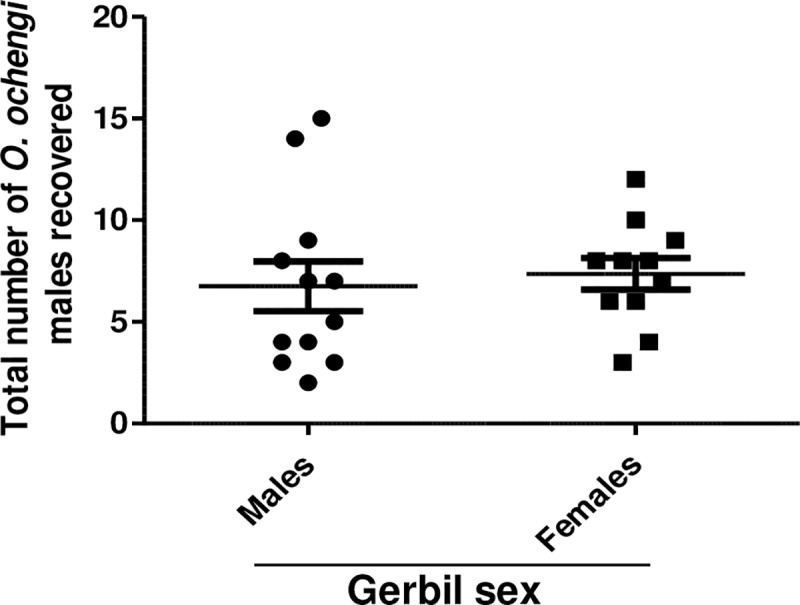
Comparison of O. ochengi male worm recovery in male and female gerbils.Gerbils were implanted with 20 O. ochengi males, sacrificed 35 days later and analyzed for total number of male worms recovered in male and female gerbils (n = 11–12 per group).